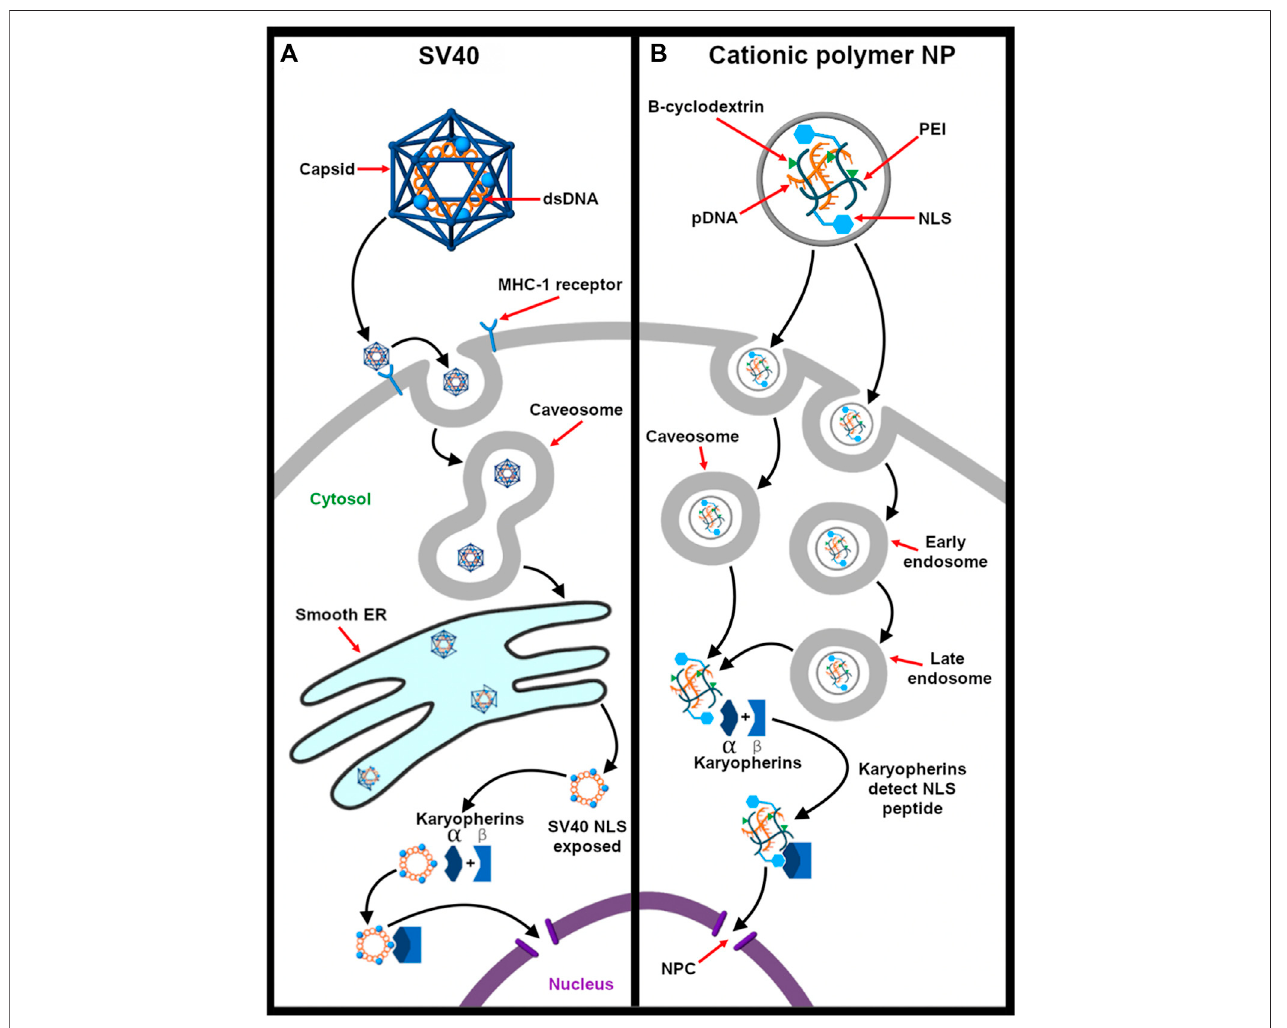
FIGURE 5 | Karyopherin-mediated nuclear delivery of SV40 and of a synthetic nanovector. (A) SV40 binds to MHC-1 class receptors present on the host cell surface. This mediates the recruitment of caveolin-1 positive vesicles, and the virus is eventually taken up into caveosomes. These caveosomes undergo dynamic structuralchangestoformlongtubularmembrane extensions,whicharethenreleasedfromcaveosomesandaretransportedtothesmoothER(Pelkmansetal.,2001). OnceinsidetheERlumen, thedisassembly ofviralcapsidbegins, andthepartiallydisassembledcapsidundergoesstructural changesinthecytosol toexposethe NLS embedded in the minor capsid. The NLS moiety is recognized by the karyopherin family, and the viral genome is transported to the nucleus as karyopherin cargo (Nakanishi et al., 2007; Toscano and de Haan 2018). (B) In this study by Hu et al. (2012), PEI conjugated to β -cyclodextrin (PC) was used to transfect pDNA. Results shows that it is internalized by caveolae- and clathrin-dependent pathways. To enhance the nuclear delivery of DNA, the NLS peptide inspired from SV40 virus was combined and conjugated to the PC backbone. Compared to PC/pDNA, PC/NLS/pDNA shows higher gene transfection ef fi ciency.